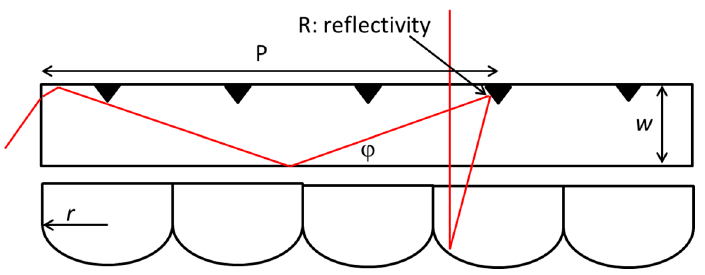
Figure 6. Lateral view of the waveguide with single ray-tracing to illustrate the theoretical calculation of optical efficiency.